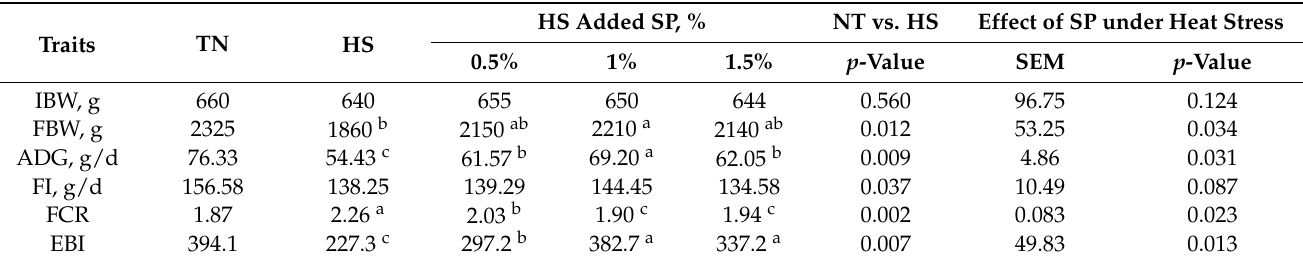
Table 2. Effect of dietary Spirulina platensis supplementation at different levels on growth performance of broiler chickens subjected to cyclic heat stress starting from 22 to 42 days of age.